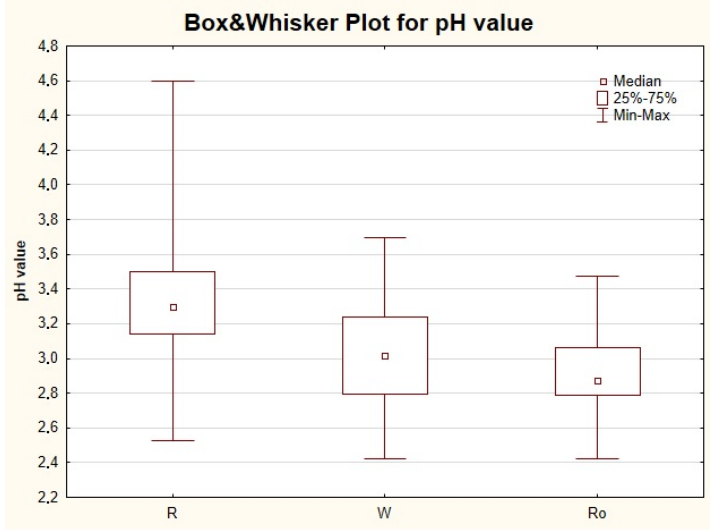
Figure 2. Box and whisker plot of pH value obtained for red (R), white (W), and rose (Ro) wines.